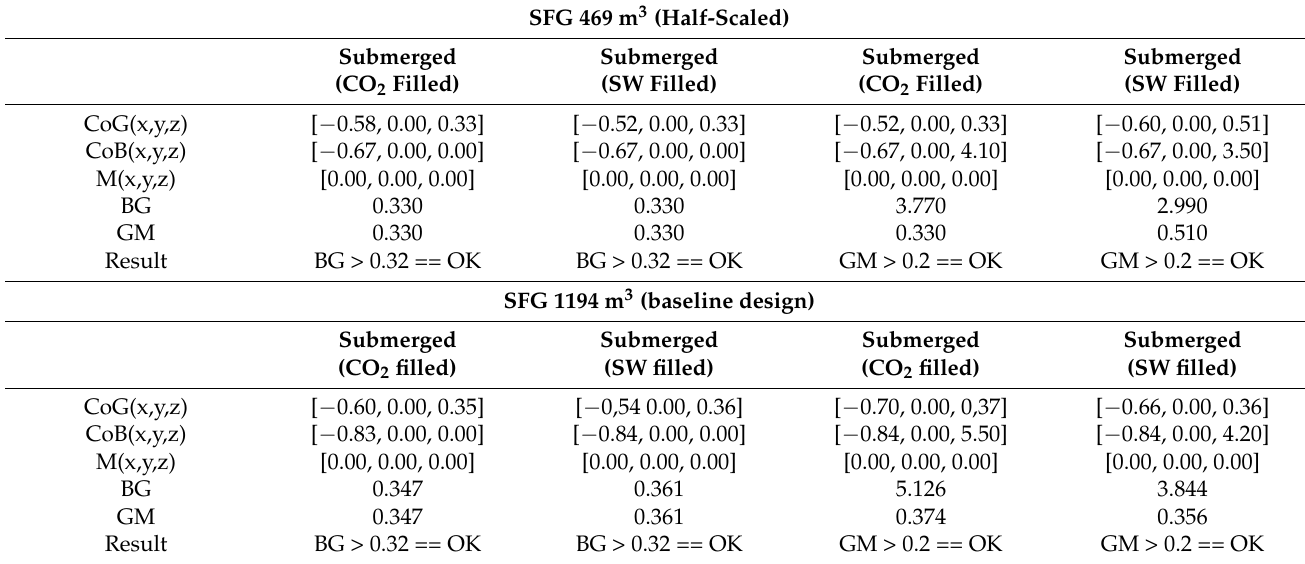
Table 7. The stability check for the three different designs of the SFG. SFG 469 m 3